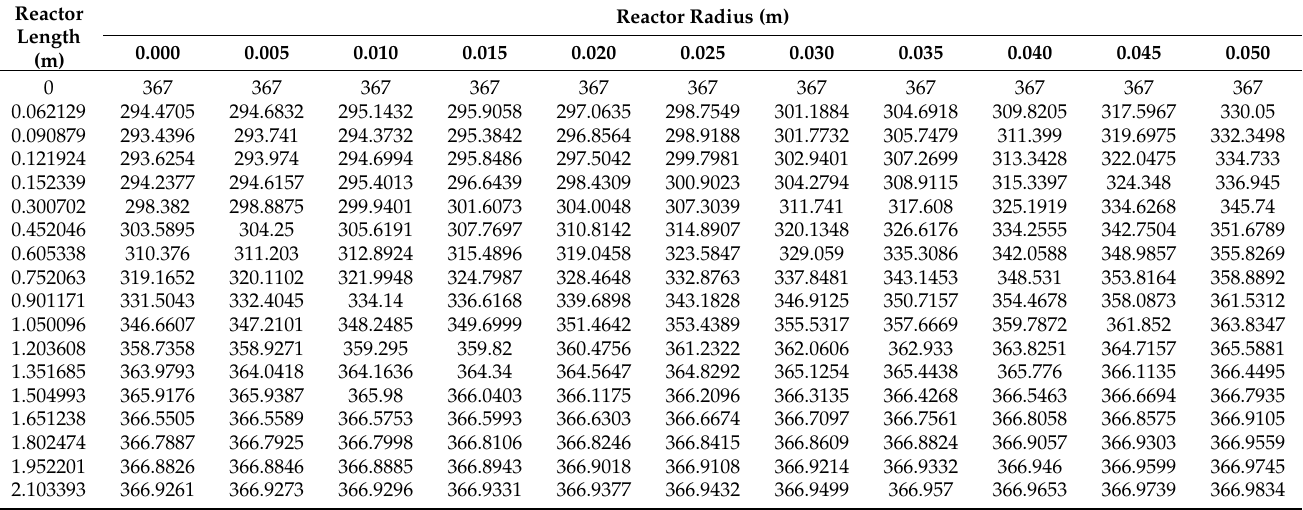
Table A2. Results of the simulation of the external temperature conditions in the catalytic bed as a function of the length and radius of the reactor. Obtained from the execution of the program reactor.pol